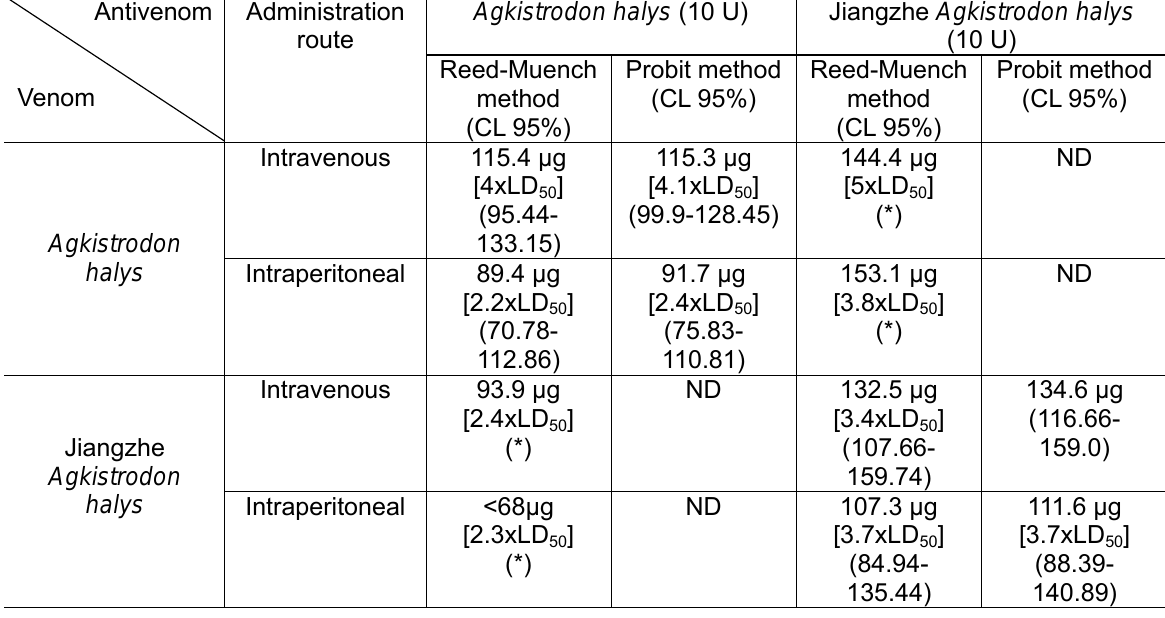
Table 2: Determination of one lethal test dose of venoms intravenously or intraperitoneally injected into mice (1 Test Dose [µg] venom/16 g mouse).